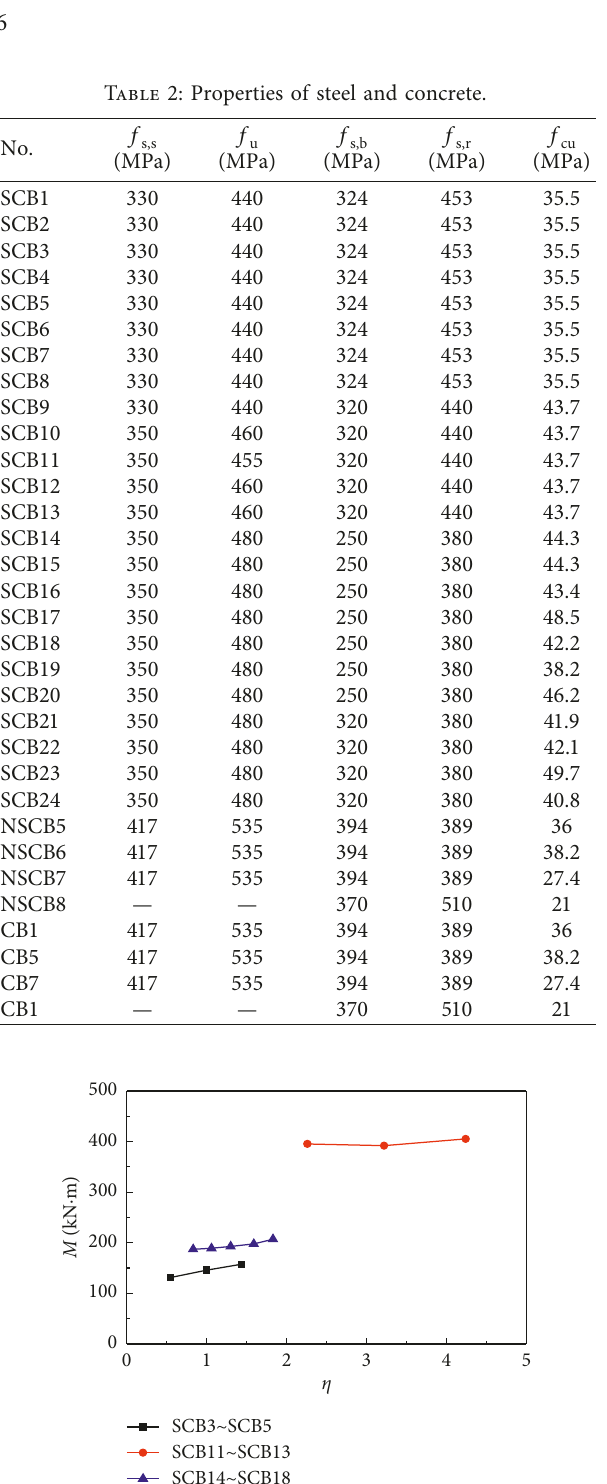
Figure 4: Relationship between M and η .